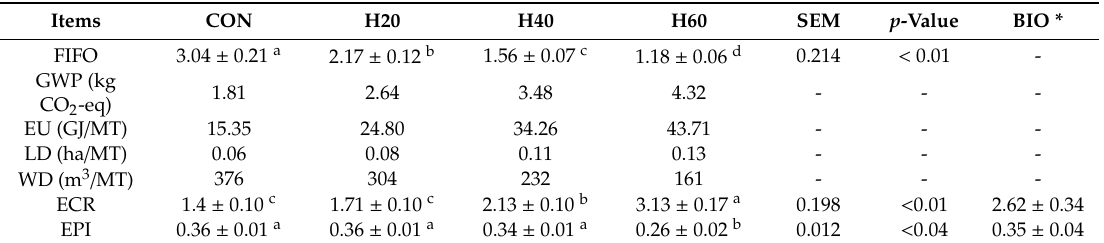
Table 9. Economic and environmental sustainability parameters of European perch production using feeds di ff ering in insect meal inclusion level (mean ± SD, n =